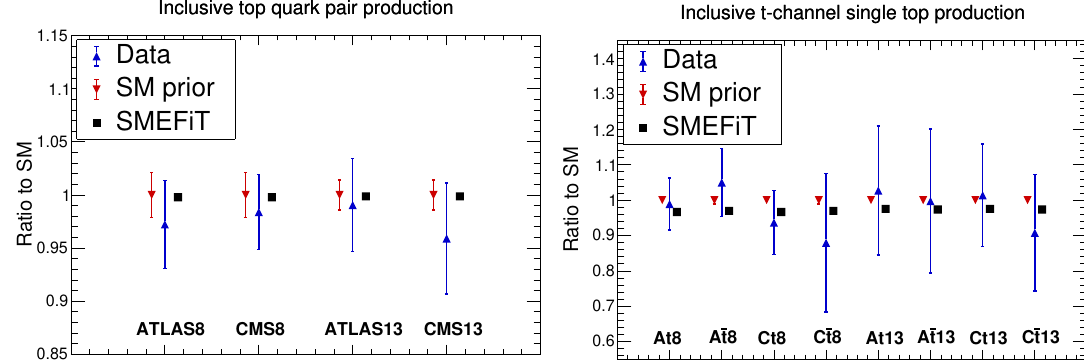
Figure 13 . Comparison between ATLAS and CMS experimental data on the total inclusive t (cid:22) t (left) and single top t -channel (right) production cross-sections at 8 TeV and 13 TeV with the